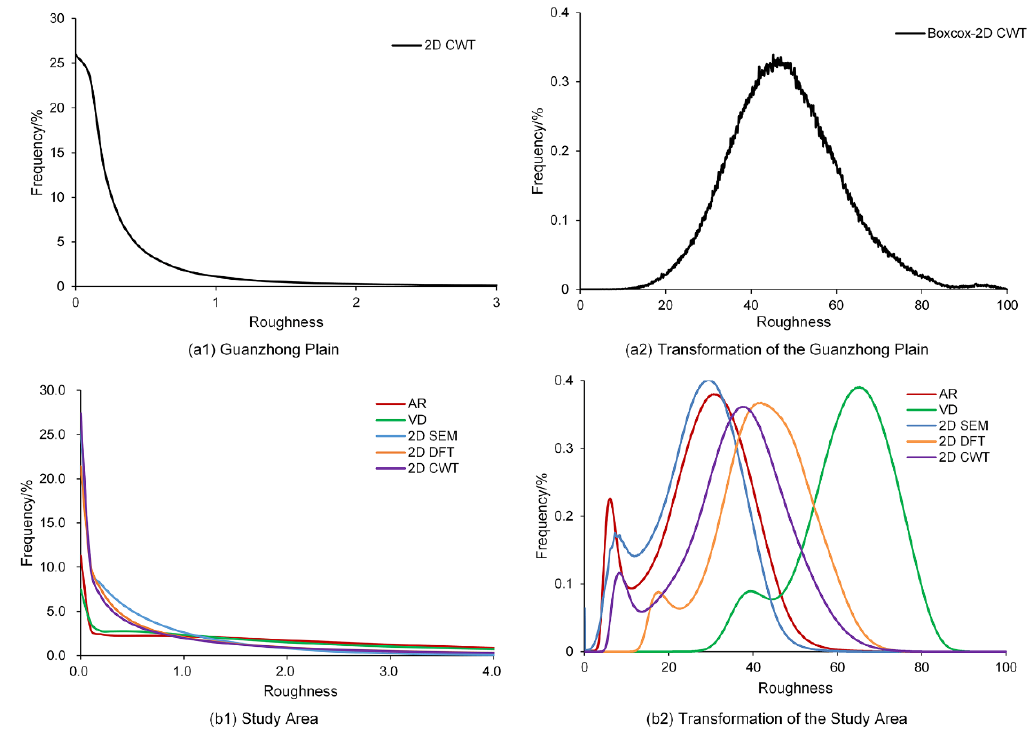
Figure 7. ( a ) The frequency curves after canonical transformation of the 2D CWT of Guanzhong plain; ( b ) The frequency curves after canonical transformation of the roughness algorithm of whole study area.